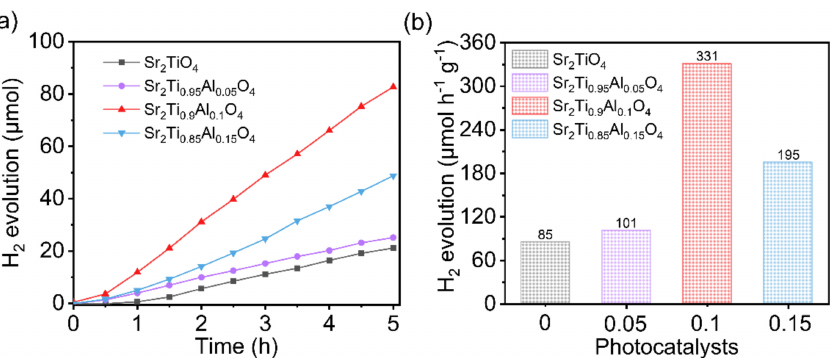
Figure 6. ( a ) H 2 evolution amounts and ( b ) average H 2 evolution rates of Sr 2 Ti 1 − x Al x O 4 (x = 0, 0.05, 0.1, and 0.15) samples under full-range sunlight illumination.